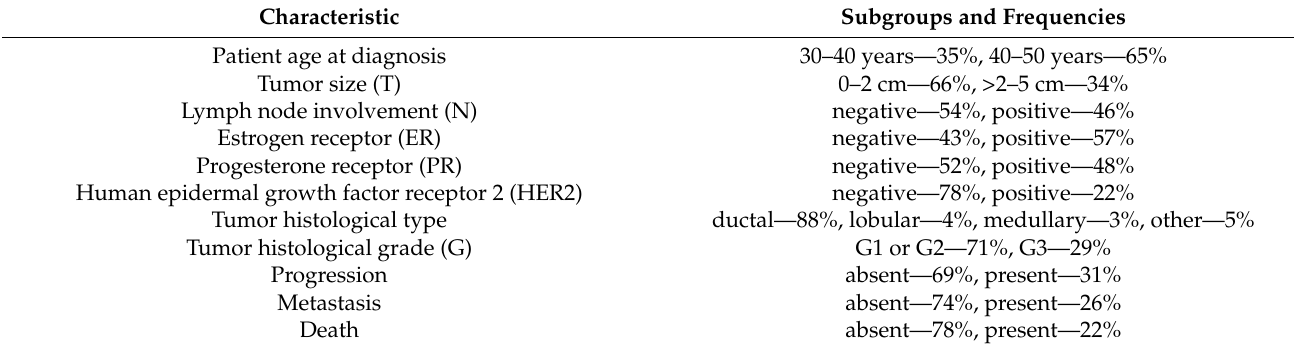
Table 2. Characteristics of the study group ( n =